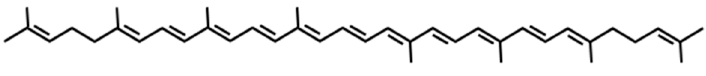
Figure 1. The chemical structure of lycopene.